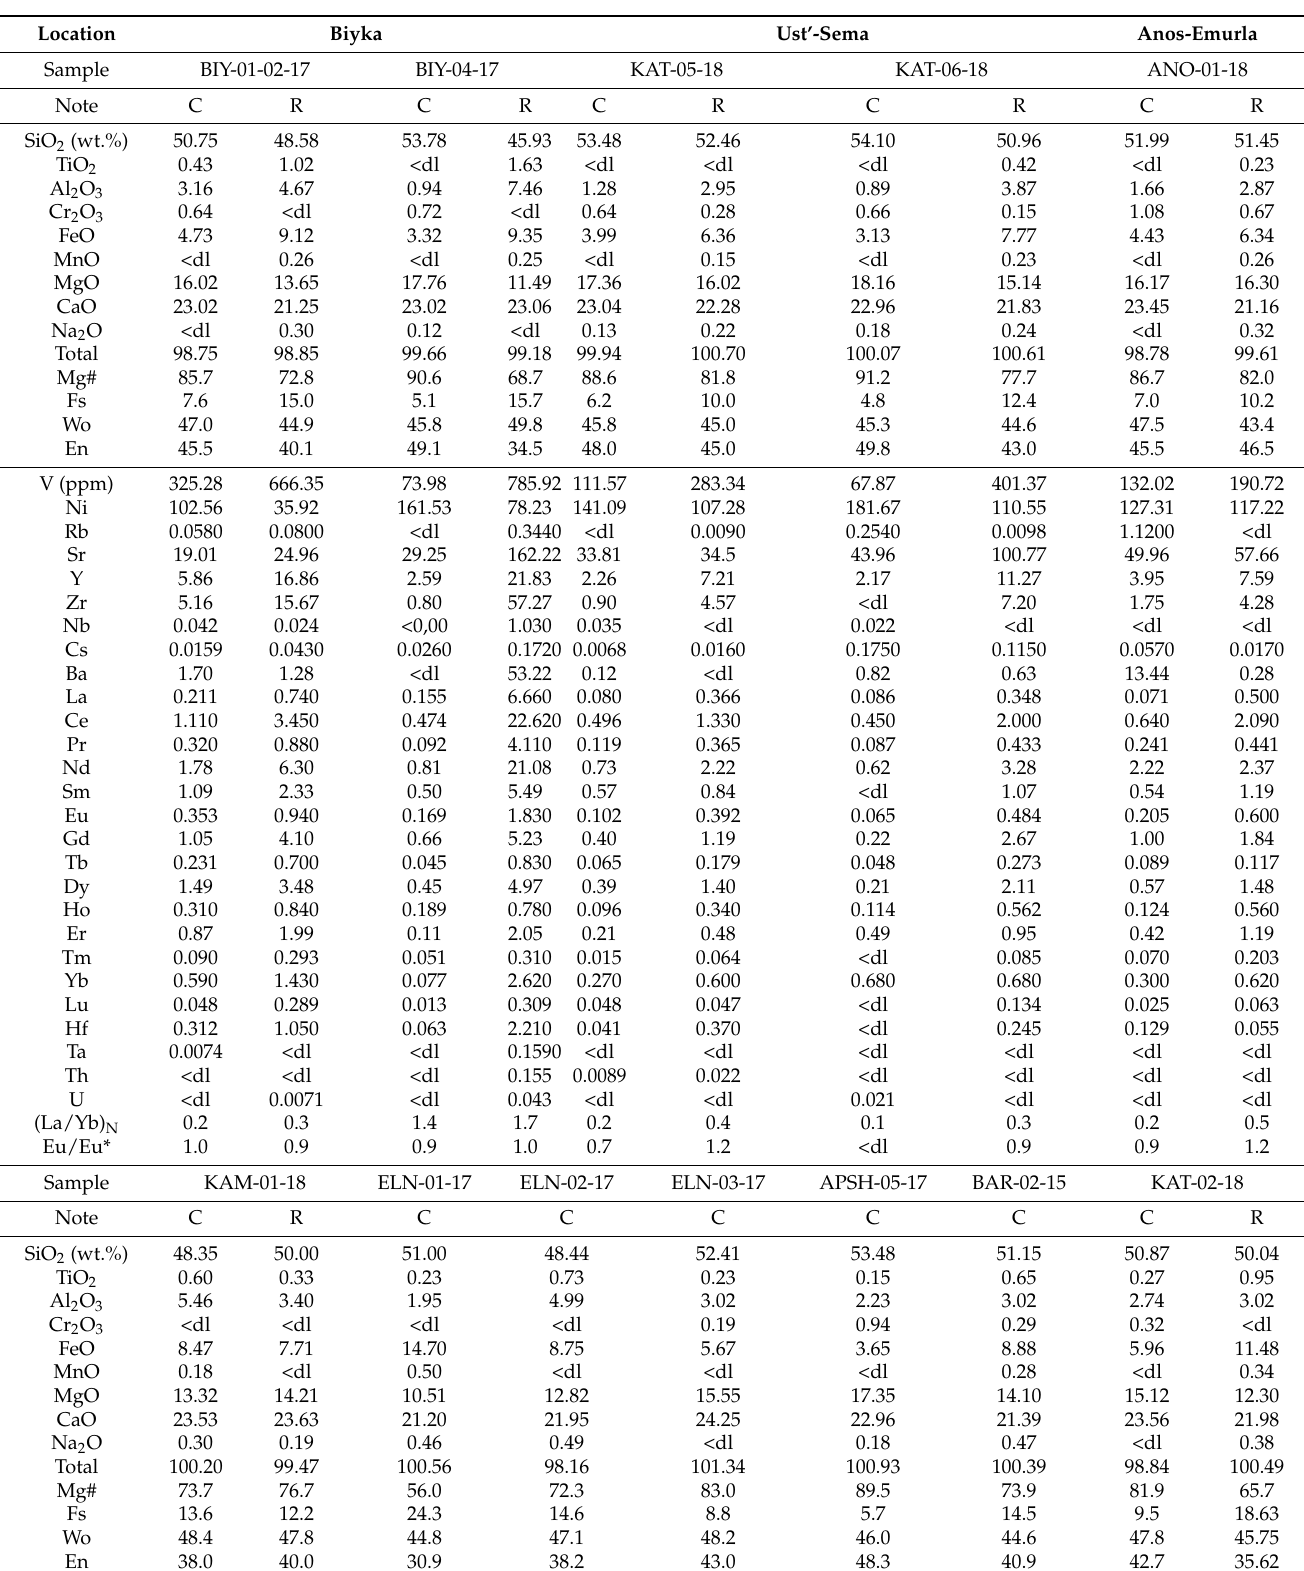
Table 2. Major (by SEM-EDS) and trace (by LA-ICP-MS) element compositions of the clinopyroxene from the Ust’-Sema Formation and the Barangol Complex rocks, Gorny